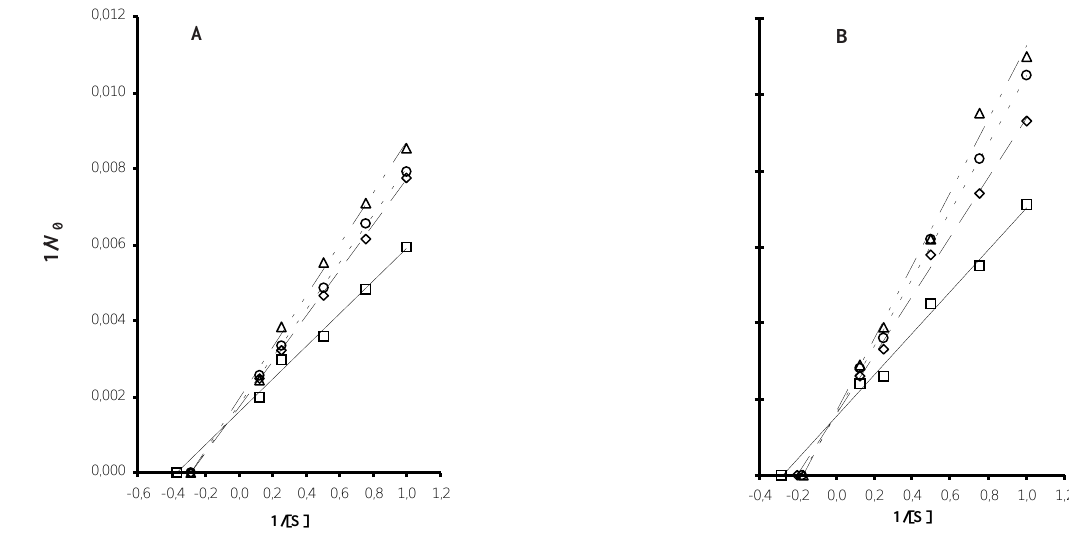
Figura 2. Gráfico de Lineweaver-Burk para as fosfatases ácidas (A) e alcalinas (B), produzidas em solo com os valores de saturação por base: 76,6% ( _____ _______ ), 68,0% ( __ __ (cid:224) (cid:224) (cid:224) (cid:224) (cid:224) __ __ ), 45,0% ( - - - - o - - - -- - - - o - - - -- - - - o - - - -- - - - o - - - -- - - - o - - - - ) e 32,0% ( .. DDDDD .. ). A concentração do substrato ([S]) e a atividade das fosfatases (V